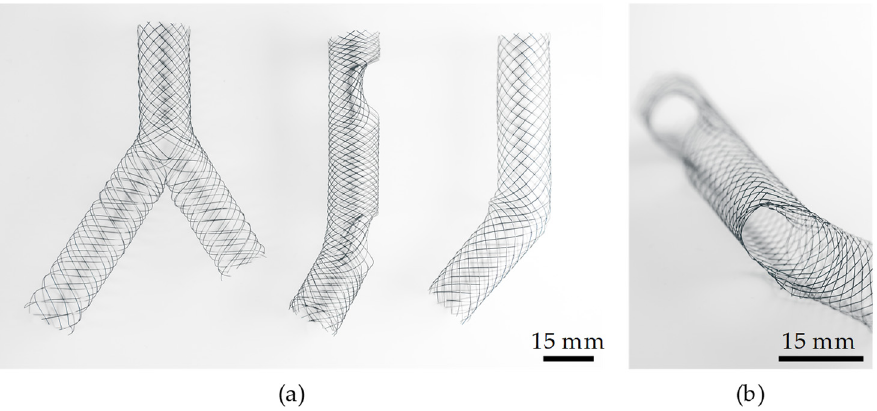
Figure 12. Complex nitinol stent structures manufactured by 3D hexagonal braiding: ( a ) bifurcation stent, stent with patient individualized cutouts, and J-stent with a diameter of 15 mm; ( b ) close-up of the cutouts created by changing the braiding pattern from a round to a flat braid.